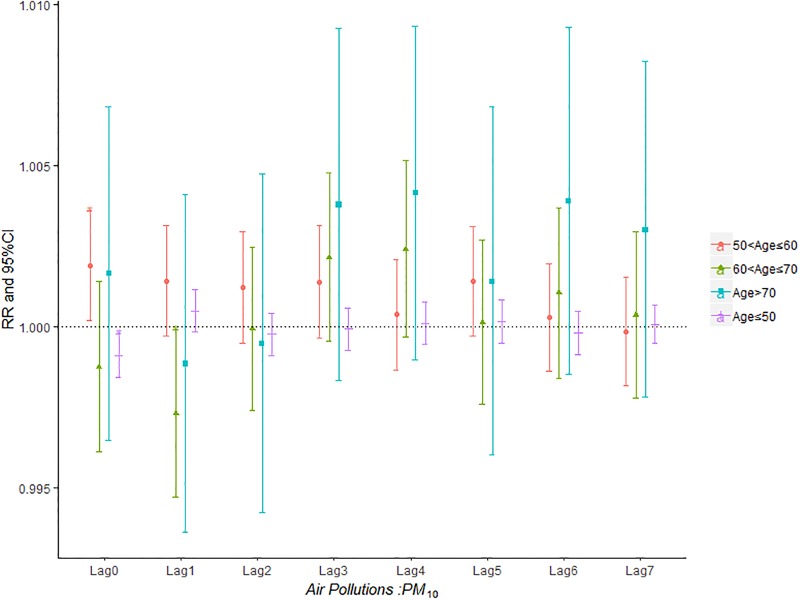
The effect of PM10 on the relative risk of AECOPD based on the stratification of age.